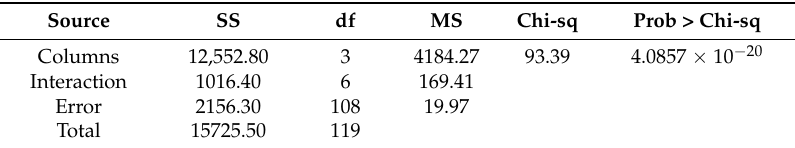
Table 12. Friedman test table for the precision metric.